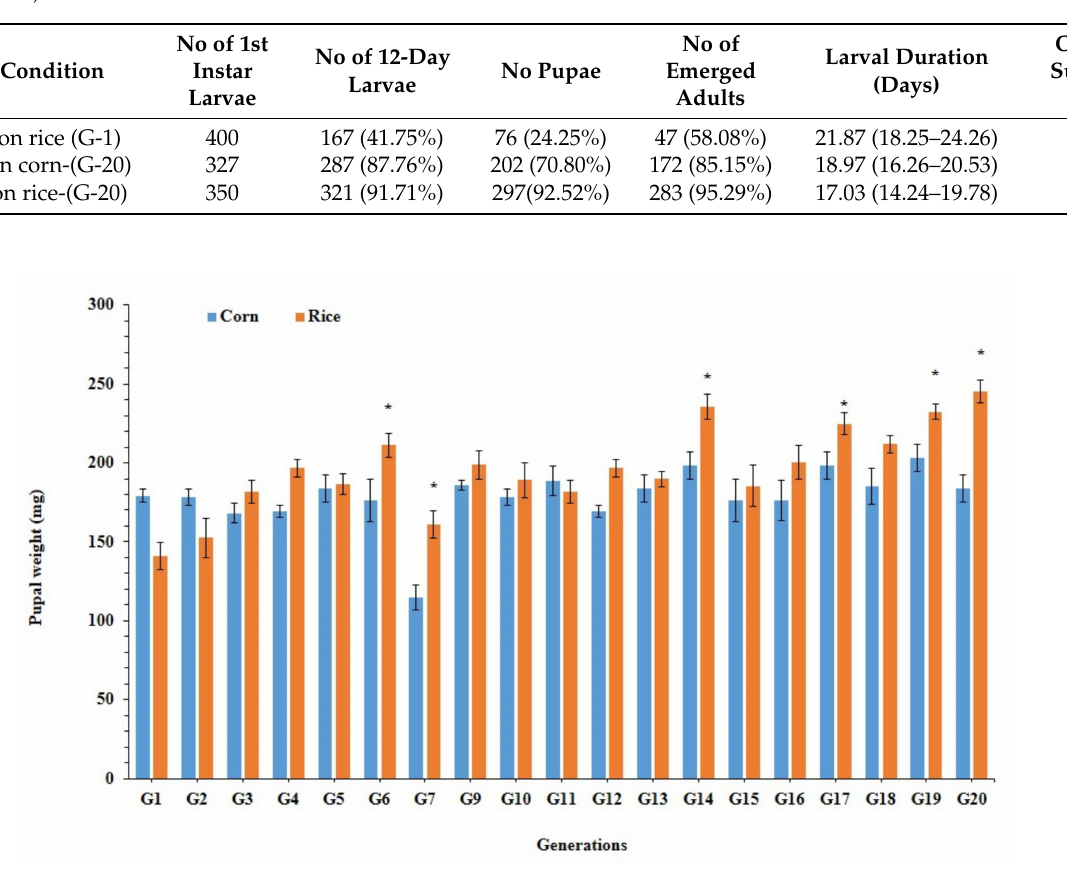
Figure 4. Average pupal weight ( ± SE) of Spodoptera frugiperda , when reared on corn and rice plants for 20 generations. Asterisks * show significant differences between hosts plants ( p < 0.05) based on post hoc Tukey’s HSD test of the Corn-Pop reared on corn vs. the Rice-Pop reared on